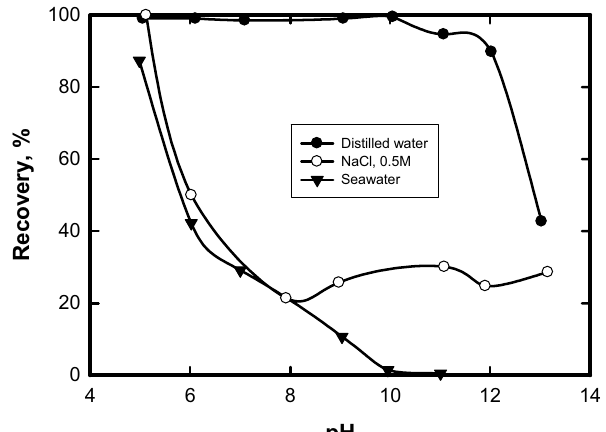
Fig. 9 Effect of pH (adjusted by NaOH/HCl) on the flotation of pyrite in a Hallimond tube (15 mg/L IsopX and 10 mg/L amyl alcohol). (Alvarez and Castro, 1976) 17)